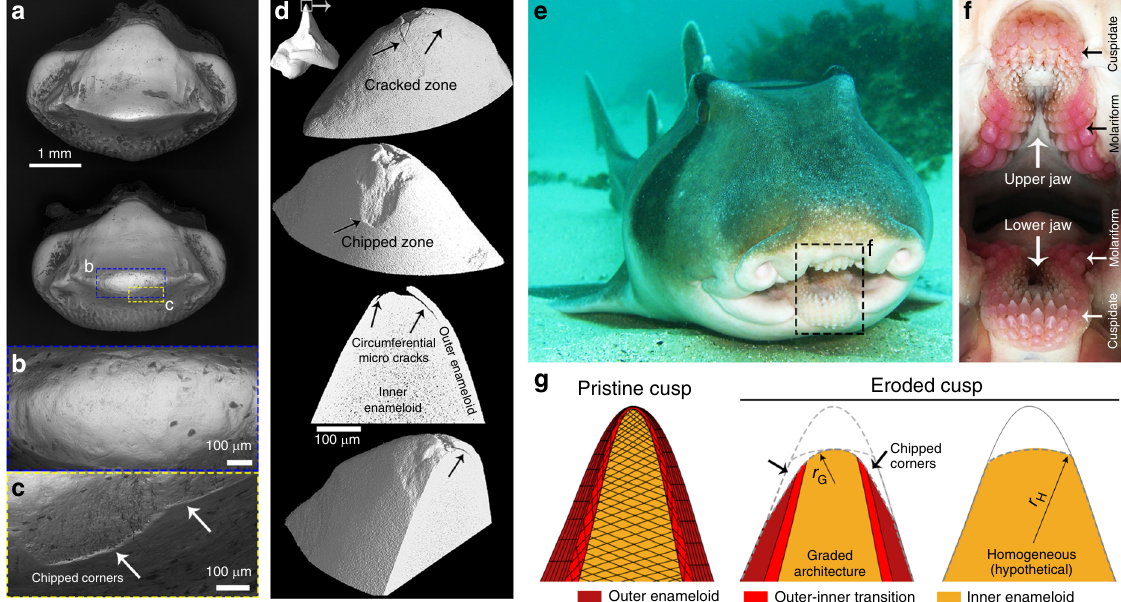
Fig. 7 Differentiated damage modes in the outer and inner enameloid, likely induced by hard targets, such as seashells, sea urchin spines/test, sand, and sediments. a – c Wide- fi eld backscattered scanning electron micrographs presenting b smooth erosion at the apex of the cusp and c chipped zones in the outer enameloid (white arrows). d High-resolution μ -CT images revealing the propagation of the circumferential microcracks beneath and along the free surface of the outer enameloid. These microcracks cause chipping damage. e Port Jackson shark photographs demonstrating the anterior grasping position of the cuspidate teeth, as points of fi rst contact with food items. In the detail photo of the mouth ( f ), the teeth are red, believed to be from repeated ingestion of sea urchins, a common hard-shelled prey item (J. Kadar, pers. comm.). g A schematic illustration of the enameloid graded architecture and corresponding damage mechanisms. The graded microarchitecture of the enameloid layers results in chipping damage in the outer layer and smooth erosion in the inner layer, which promotes a higher rate of damage in the outer enameloid, and consequently a self-sharpening mechanism at the cusp. The estimated radii of an eroded cusp with a graded architecture ( r G ) and an eroded cusp with any given homogeneous architecture ( r H )